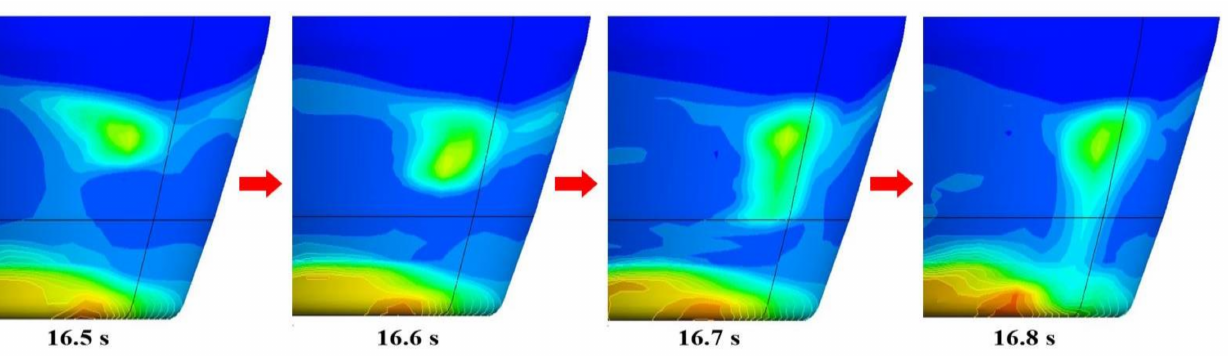
Figure 15. Condensation Phenomenon in HSVC, Model